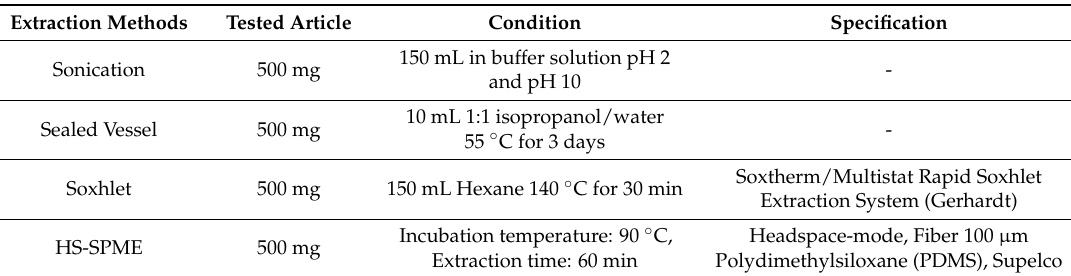
Table 2. Extraction methods specification.